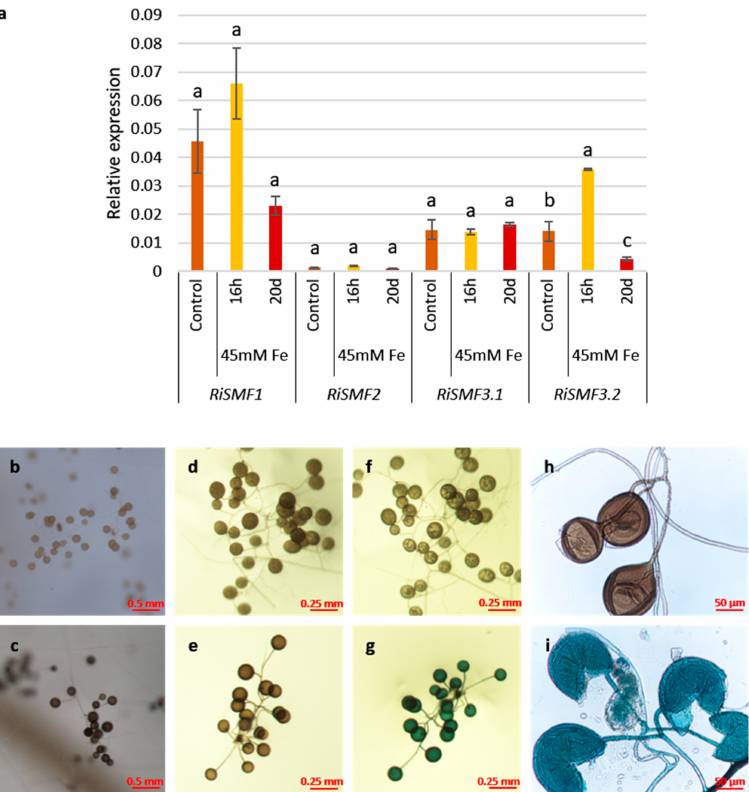
Figure 8. Effect of Fe toxicity on ERM RiSMF s expression and Fe accumulation. ( a ) Gene expression was analysed in RNAs isolated from ERM developed in monoxenic cultures in M medium (control), M medium and exposed 3 d for 16 h to 45 mM Fe (16 h) or grown for 20 d in media supplemented with 45 mM Fe (20 d). Relative expression levels were calculated, using the 2 − ∆ CT method with RiEF1 α as internal control. Bars represent standard error. Different letters indicate significant differences ( p < 0.05; n = 3), in comparison to the corresponding control value. ( b – i ) Fe detection in the ERM by Perls staining. ERM grown in M media supplemented with H 2 O (b, control) or supplemented with 45 mM Fe (c, Fe toxicity). Spores from the control plates ( b , d , f , h ) and from the Fe-toxicity conditions ( c , e , g , i ), before ( d , e ) and after ( f – i ) the addition of Perls stain solution. Crushed spores developed under control, ( h ) Fe toxicity ( i ) and exposed to Perls stain solution. Blue precipitate indicates Fe